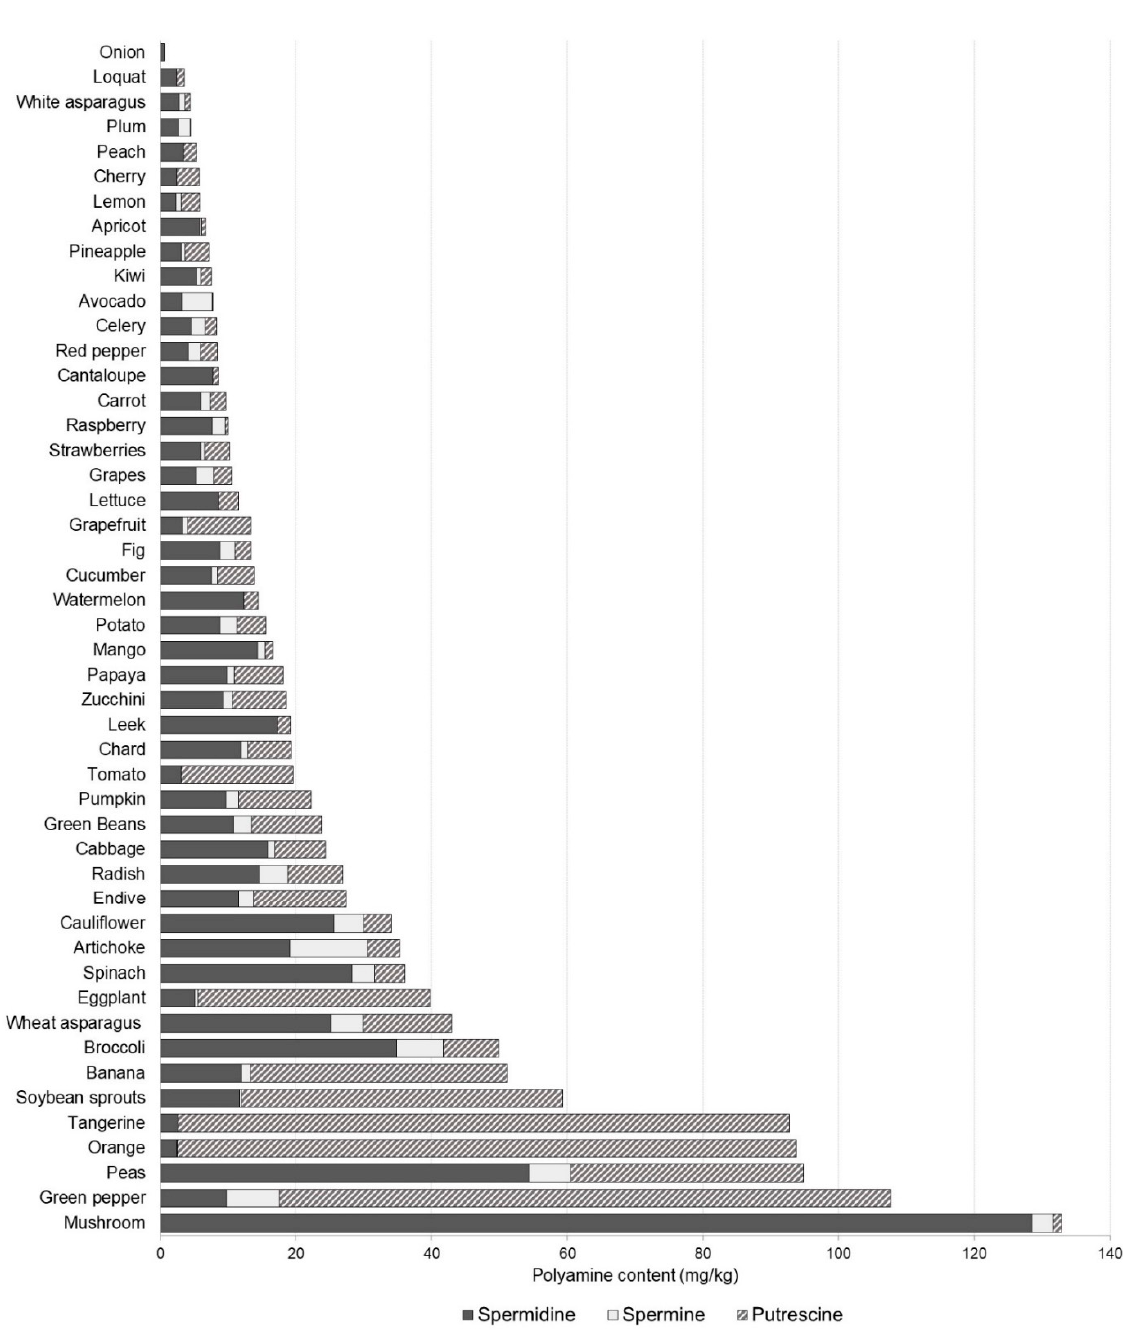
Figure 3. Polyamine profile and content (mg/kg) in vegetables and fruit.